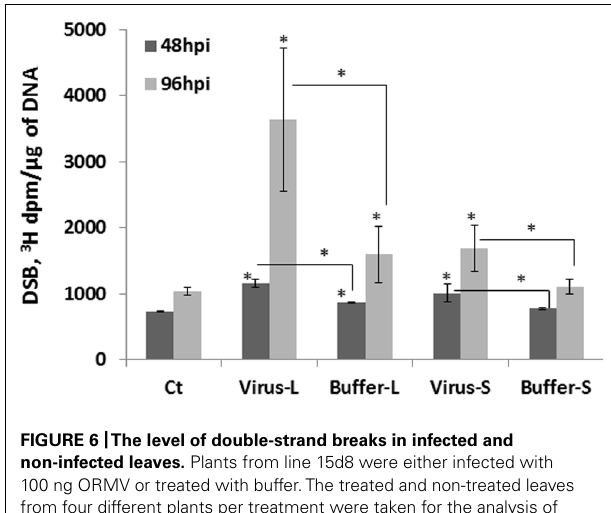
FIGURE 6 |The level of double-strand breaks in infected and non-infected leaves. Plants from line 15d8 were either infected with 100 ng ORMV or treated with buffer.The treated and non-treated leaves from four different plants per treatment were taken for the analysis of double strand breaks (DSBs) by the ROPS assay.The data are shown as 3 H incorporation in dpm/ μ g of DNA.The asterisks show a significant difference between the treated groups (virus or buffer) and the control as well as between the virus-treated and buffer-treated groups ( P <